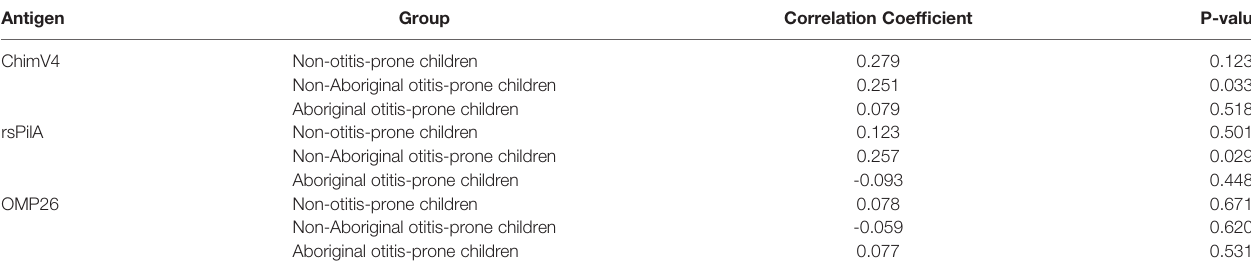
TABLE 2 | Correlation of antigen speci fi c IgG titres with age.